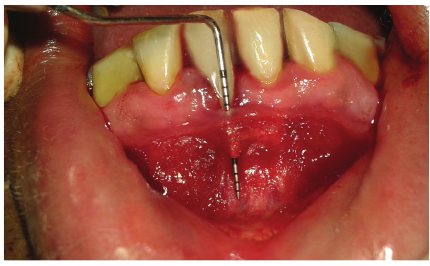
Figure 1: Preoperative view.